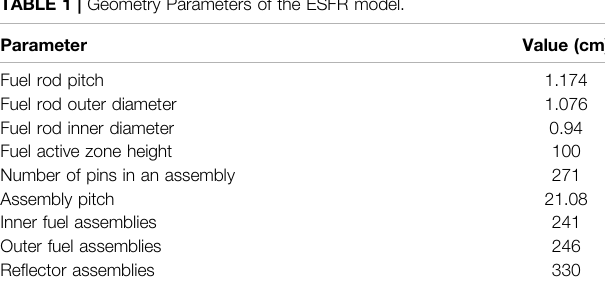
TABLE 1 | Geometry Parameters of the ESFR